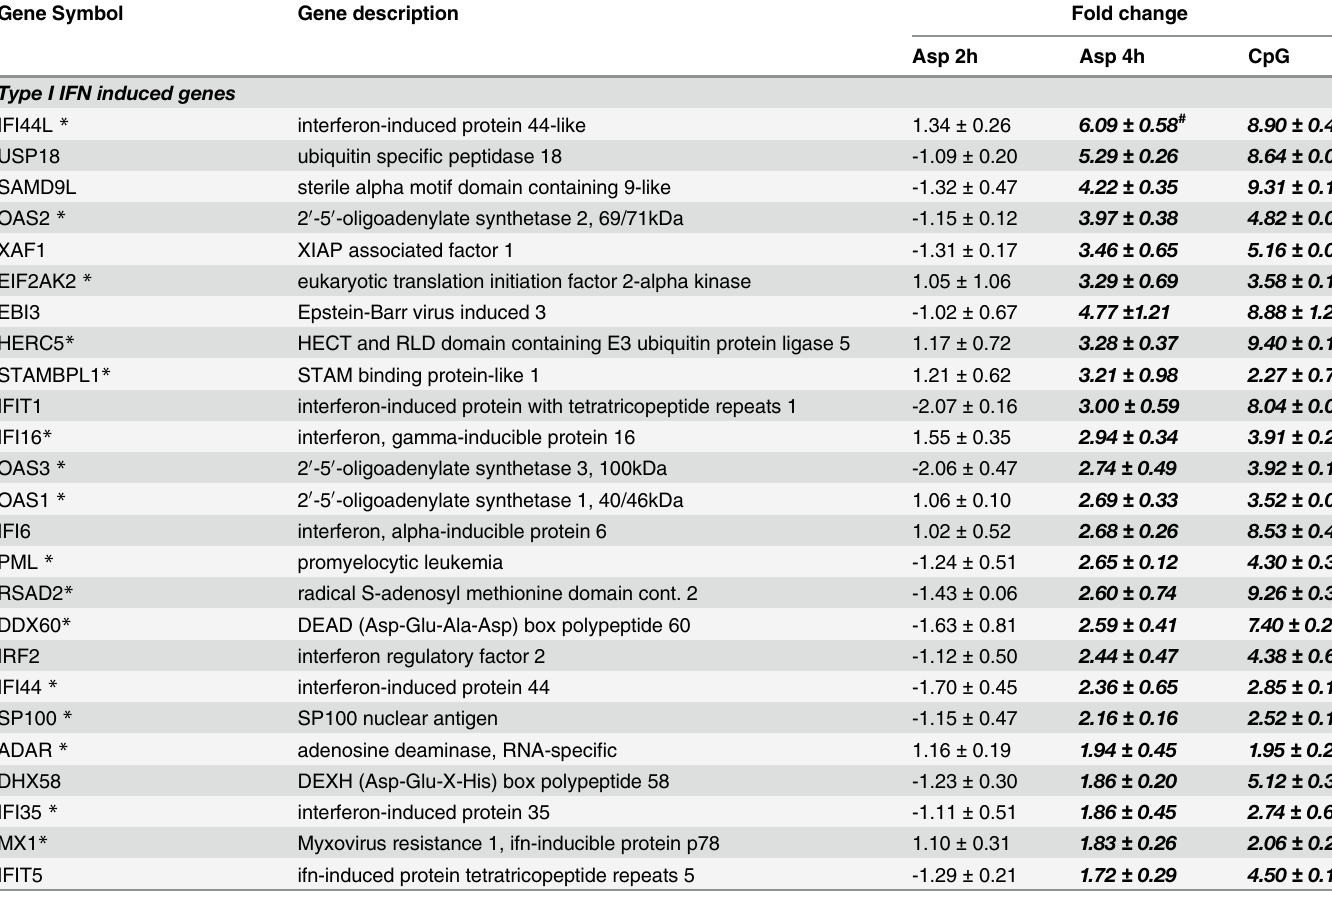
Table 3. Type I Interferon-induced